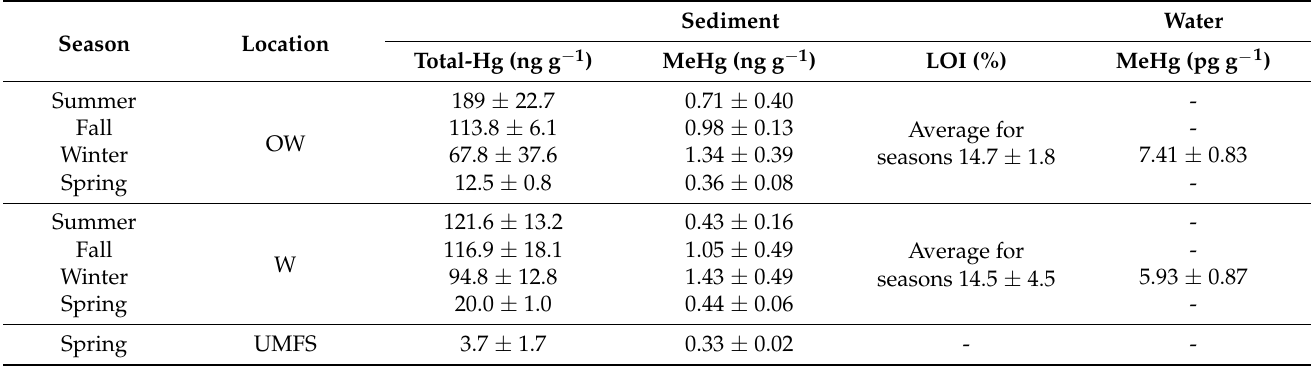
Table 4. Concentrations of bulk samples of the same sediment for total Hg and MeHg in sediment and water from Sky Lake wetland and open water areas, as well as loss on ignition (LOI), an estimate of organic matter in the